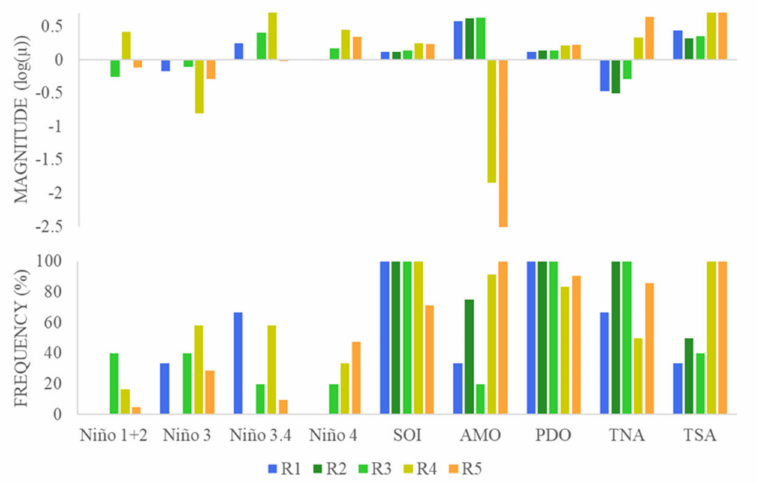
Figure 3. Magnitude of the parameter µ for each of the five homogeneous study regions (R1–R5), associated with the climatic indices and their absolute frequency under S1 at the 5% significance level in the state of Para í